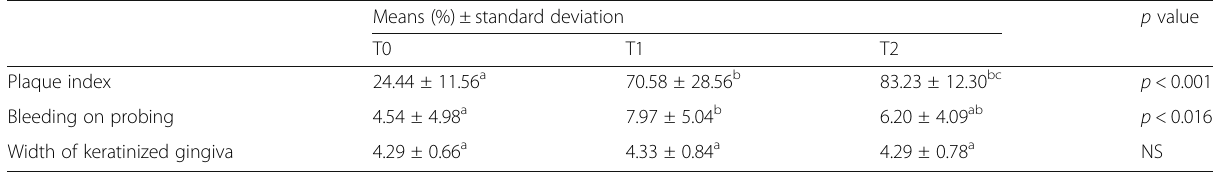
Table 2 Means and standard deviations of clinical parameters at T0, T1, and T2 (baseline, 6 and 12 months) of orthodontic treatment Means (%) ± standard